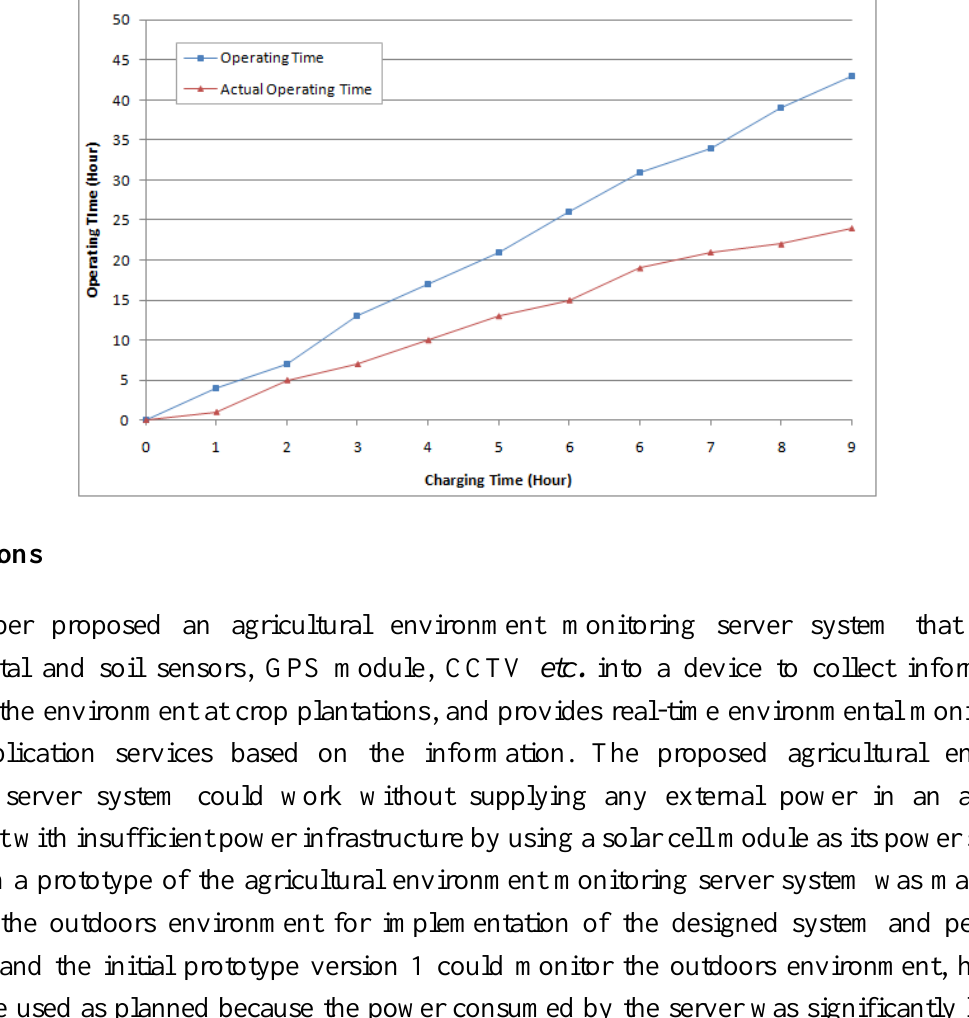
Figure 20. Field Test Result on Power Consumption of the Proposed